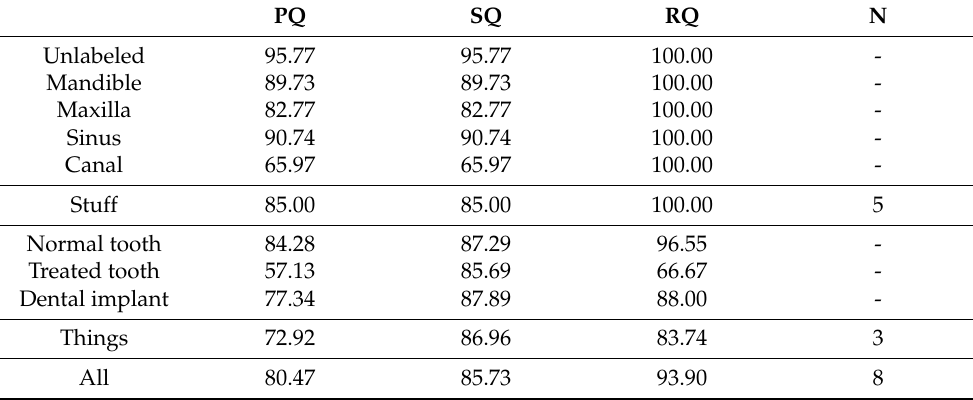
Table 1. Panoptic quality (PQ), segmentation quality (SQ), and recognition quality (RQ). PQ Unlabeled